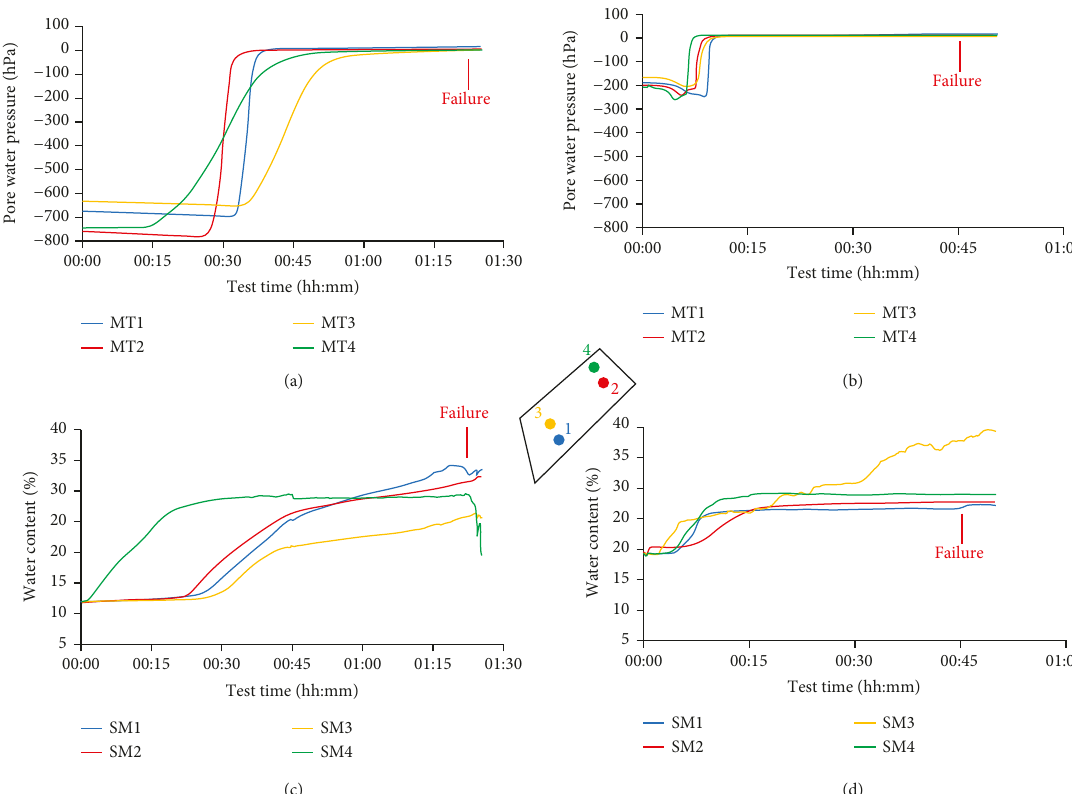
Figure 8: Pore water pressure (a and b) and soil moisture data (c and d) recorded during test n.3 ( α = 32 ° , w = 11 9% ) and test n.5 ( α = 32 ° , w = 19 2% ),